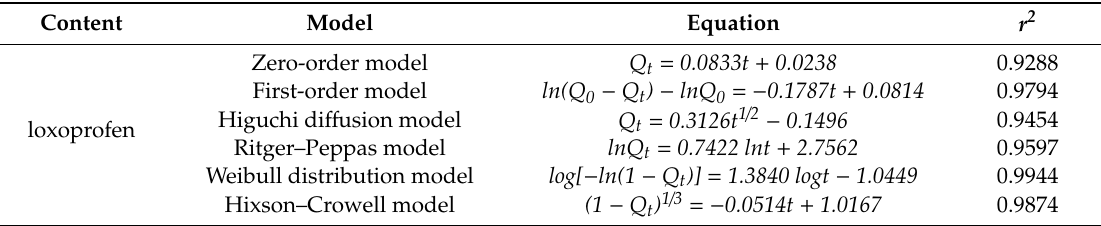
Table 5. Models simulated for the drug release profiles of the optimal